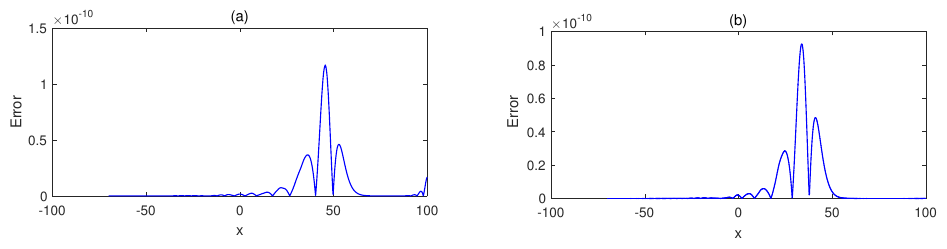
Figure 4. The absolute error L ∞ with τ = h = 0.05, at final times T = 30 ( a ) and T = 40 ( b ) over the interval x ∈ [ − 70,100 ] for Example 1.